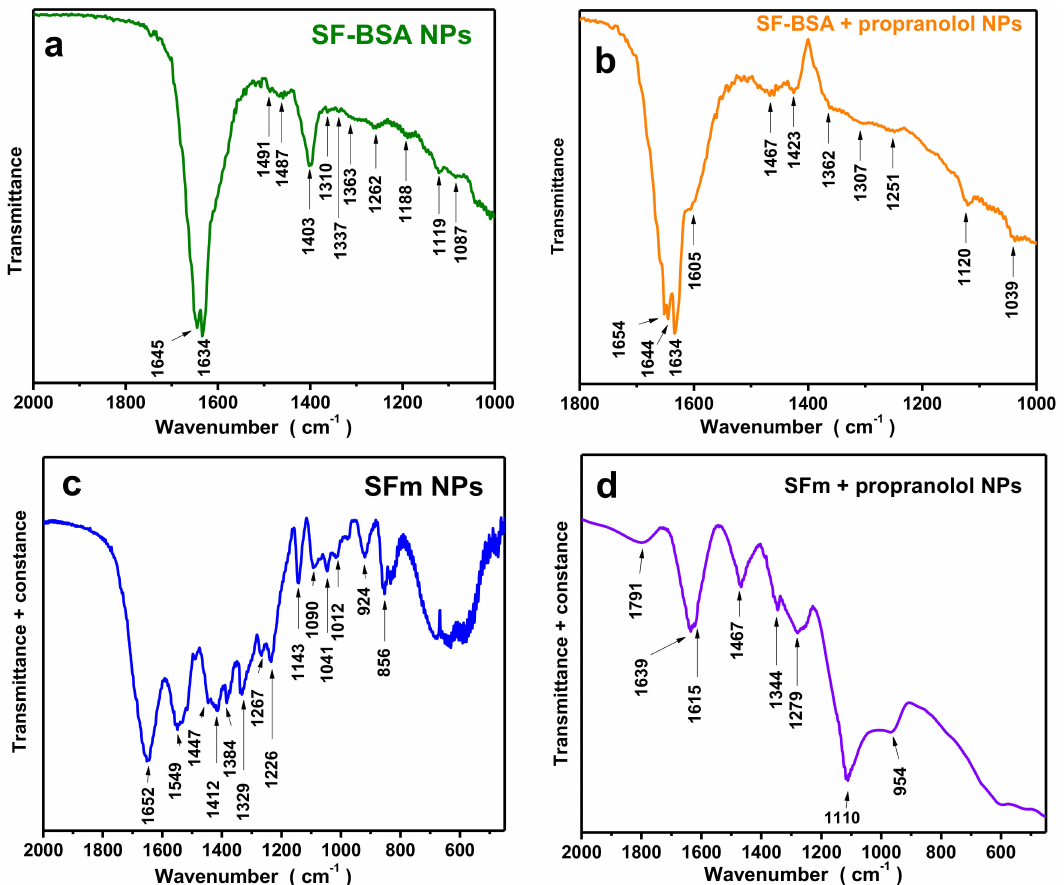
Figure 7. FTIRspectra of: ( a )silk fibroin-bovine serum albuminnanoparticles; ( b )propranolol-encapsulated silk fibroin-bovine serum albumin nanoparticles; ( c ) magnetic silk nanoparticles; and ( d ) propranolol-encapsulated magnetic silk fibroin